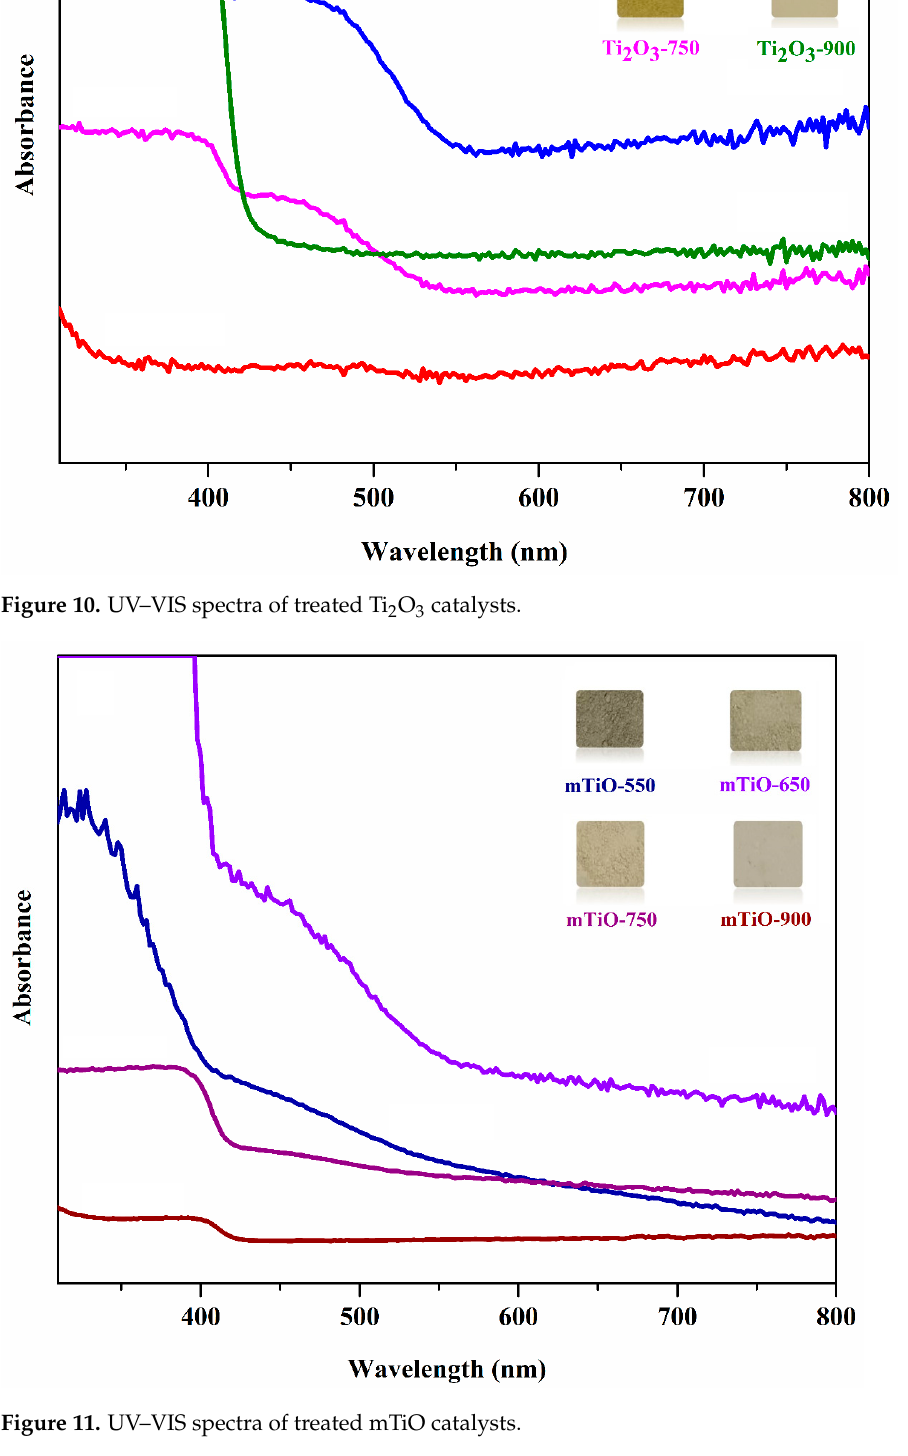
Figure 11. UV–VIS spectra of treated mTiO catalysts.